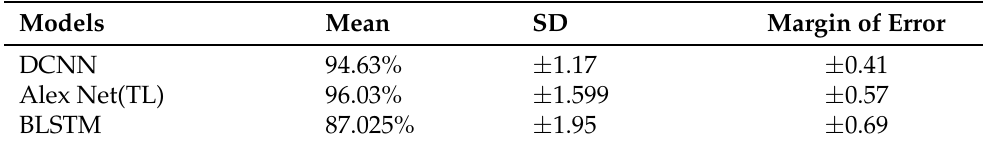
Table 5. Alphabet classification values of mean, standard deviation, and